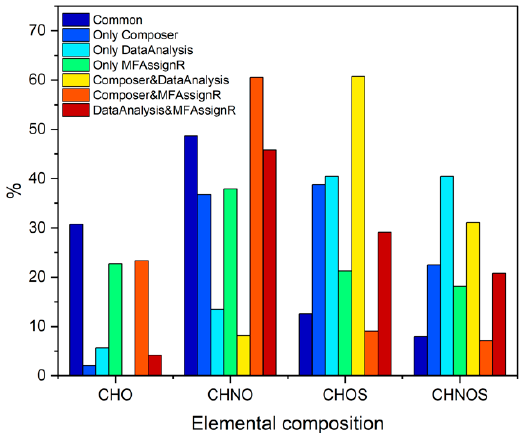
Figure 8. Comparison of the number of compounds (in percentage on the number of MF) containing carbon, hydrogen, and oxygen (CHO); carbon, hydrogen, nitrogen, and oxygen (CHNO); carbon, hydrogen, oxygen, and sulfur (CHOS); and all five elements (CHNOS) for the seven fractions of the Venn diagram shown in Figure 7a.